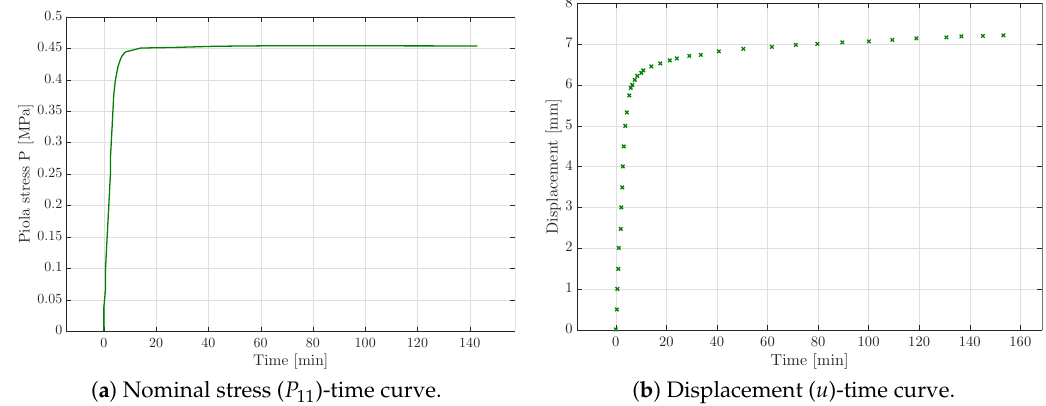
Figure 4. Creep test results of the micro-testing machine, where the stress is fixed over time ( a ) in order to measure the displacement change ( b